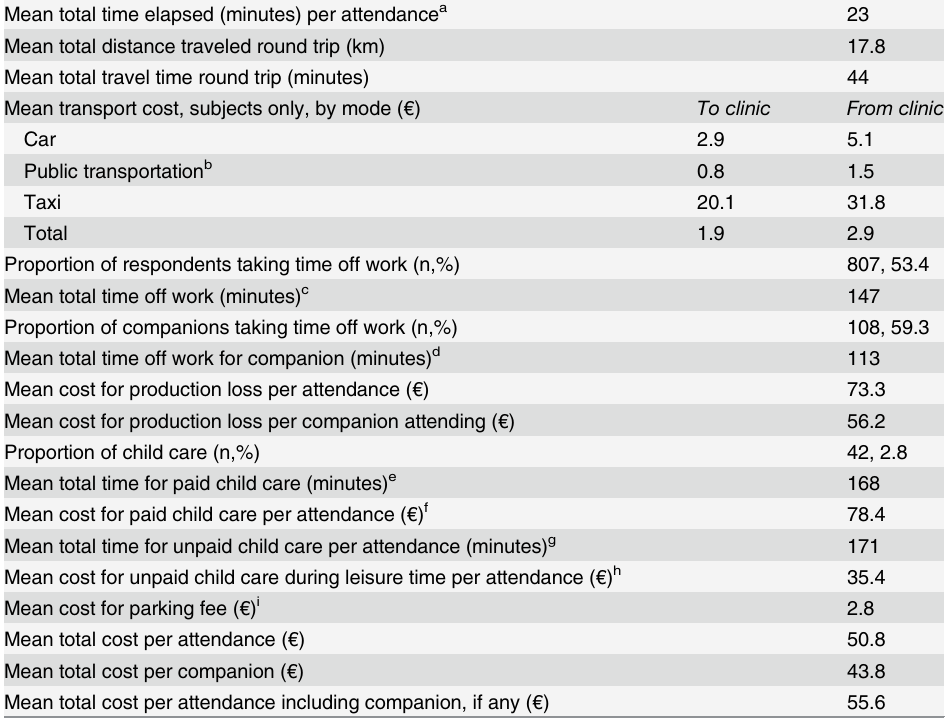
Table 3. Time and travel costs, direct non-medical costs and other related variables for 1510 women attending the clinic-based cervical cancer screening program in Sweden. Mean total time elapsed (minutes) per attendance a Mean total distance traveled round trip